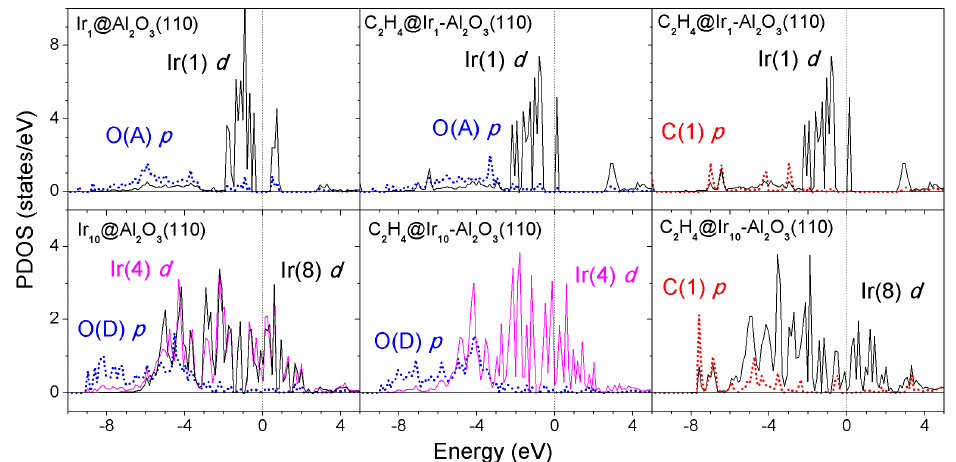
Figure 8. Density of states for the supported Ir 1 (upper row) and Ir 10 (bottom row) clusters on the hydrated γ -Al 2 O 3 (110) surface projected on the bonded Ir atom, surface O, and C in the adsorbed ethylene ( π mode) before and after ethylene adsorption. (Dotted lines: p states; solid lines: d states.).